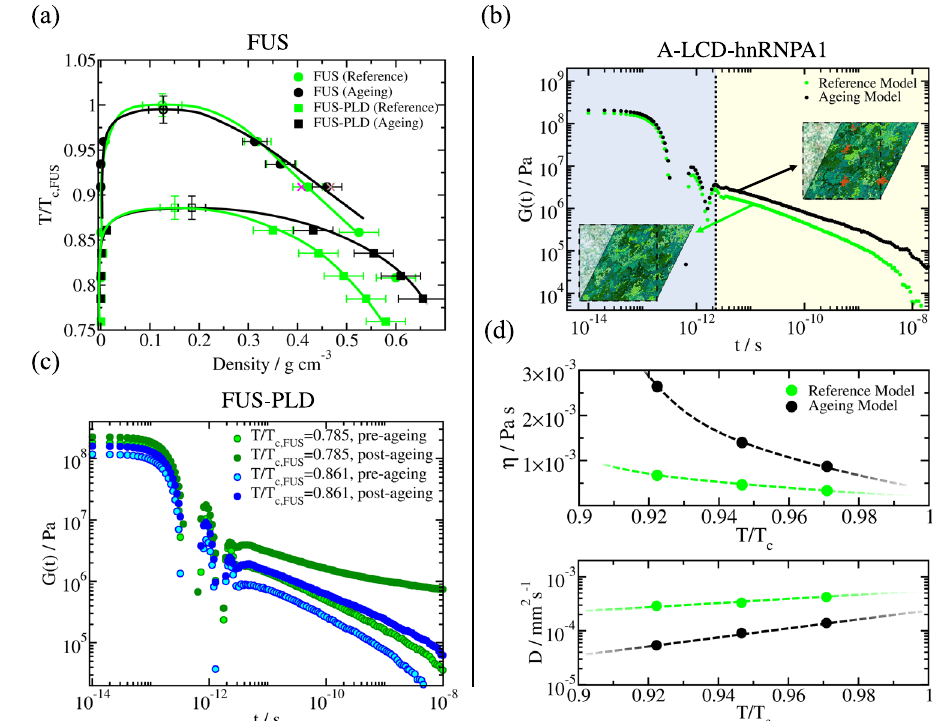
Fig. 2 | Protein structural transitions severely impact the viscoelastic beha- viourofFUSand A-LCD-hnRNPA1 condensates.a Phase diagram in the T- ρ plane for full-FUS (circles) and FUS-PLD (squares) sequences before disorder-to- β -sheet transitions take place (green symbols), and after condensates become kinetically arrested (black symbols; dynamical algorithm). Filled symbols represent the coex- istence densities obtained via Direct Coexistence simulations 145 , while empty sym- bolsdepicttheestimatedcriticalpointsbymeansofthelawofrectilineardiameters and criticalexponents 146 .Purpleandbrowncrossesdepictcoexistencedensitiesfor the full-FUS referencemodel and ageing model respectively using system sizes two times larger (i.e., 96 protein replicas). Temperature has been normalized by the critical temperature of full-FUS (T c , FUS ) for the reference model 107,108 . Statistical errors are obtained by bootstrapping results from n = 3 independent simulations. b Shear stress relaxation modulus G ( t ) of the A-LCD-hnRNPA1 bulk condensed phaseat T =0.92 T c forthereferencemodel(greencurve;HPS-Cation- π model 107,108 ), and for proteincondensates in which local strengthening of LARKS proteinbinding due to structural transitions is accounted (black curve; dynamical ageing model).